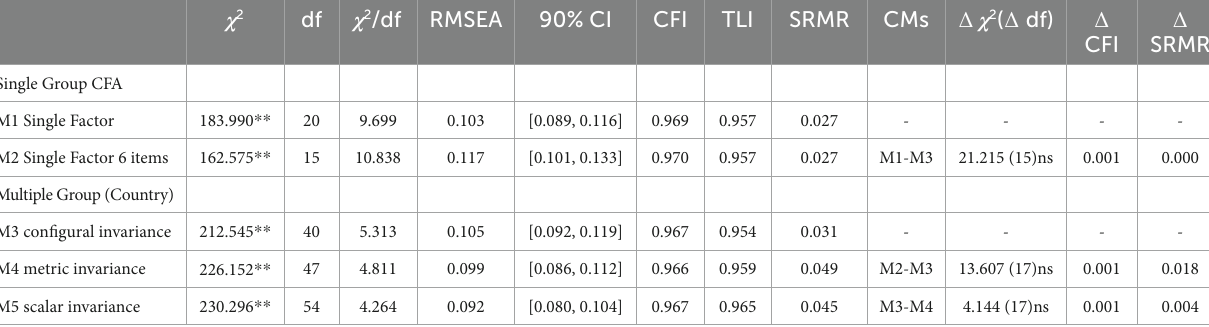
TABLE 6 Fit indexes for single group and multi-group confirmatory factor analyzes for the strengths knowledge scale (study 2). χ 2